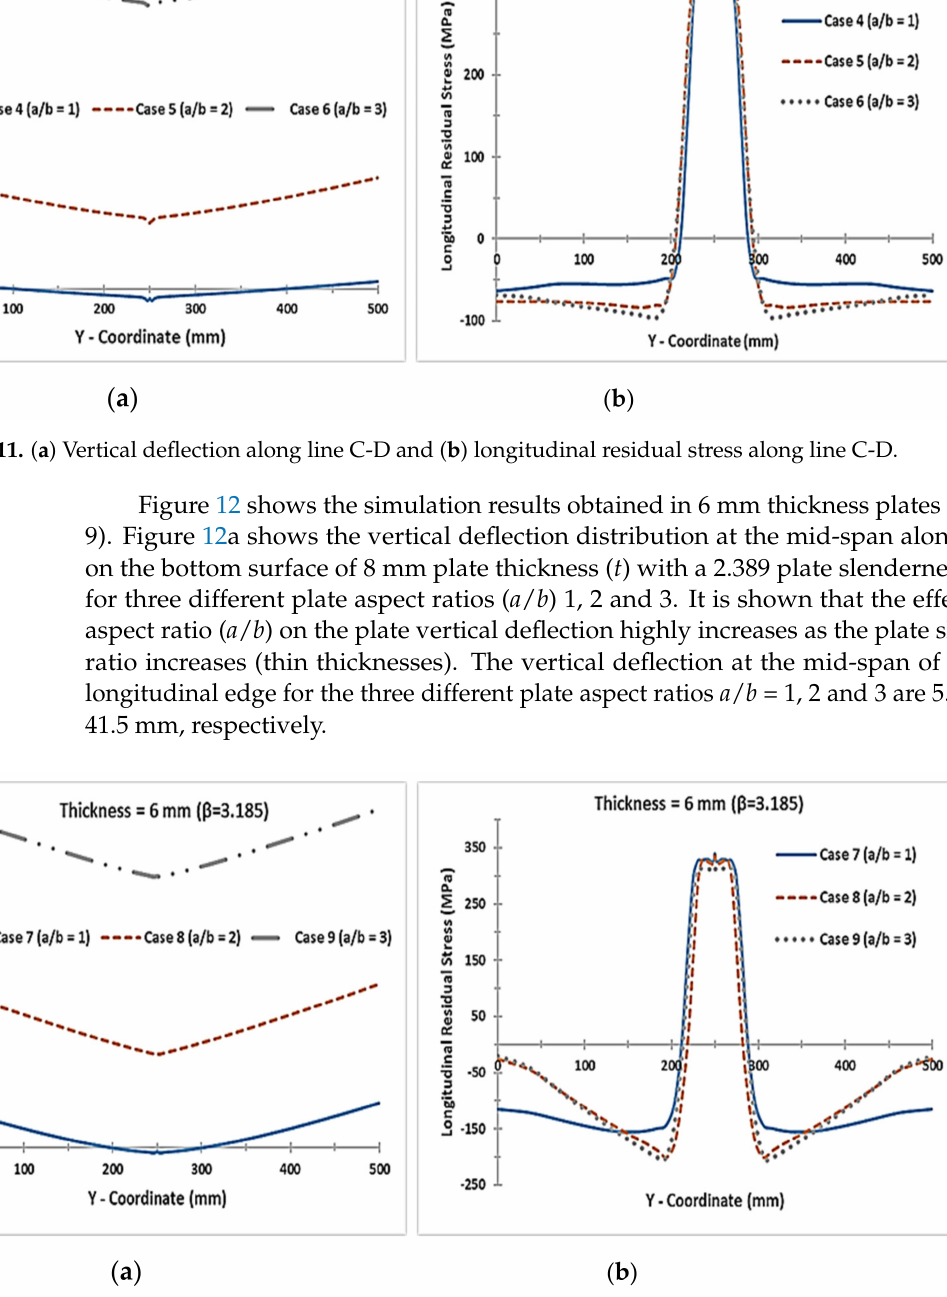
Figure 12. ( a ) Vertical deflection along line C-D and ( b ) longitudinal residual stress along line C-D. The longitudinal stress distribution through the plate panel breath at the mid-span of the model along line C-D on the bottom surface of 6 mm plate thickness ( t ) with a 3.185 plate slenderness ratio ( β ) for three different plate aspect ratios ( a / b ) 1, 2 and 3 is plotted in Figure 12b. It is noticeable that increasing the plate aspect ratio for thin plates highly affected the plate’s compressive residual stress distribution and magnitude near HAZ. Plates with aspect ratio a / b = 2 and 3 have almost the same residual stress